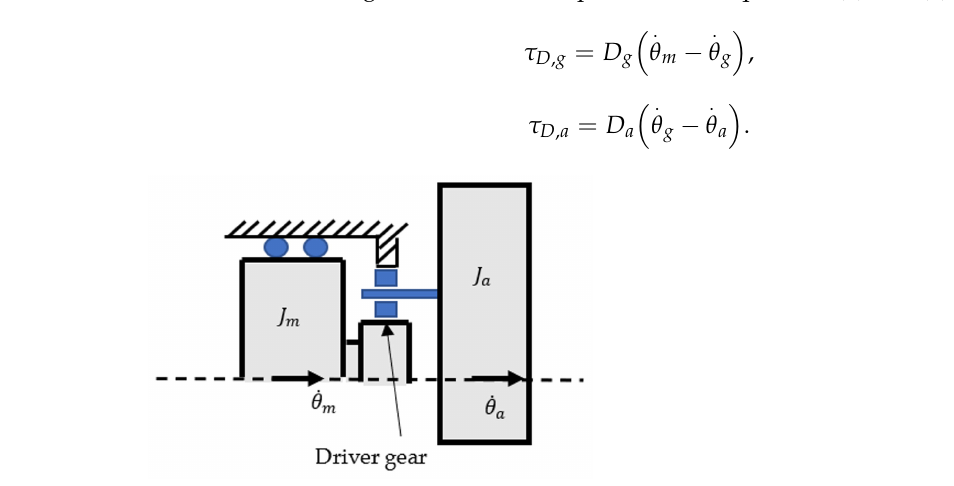
Figure 2. Nonlinear robotic arm